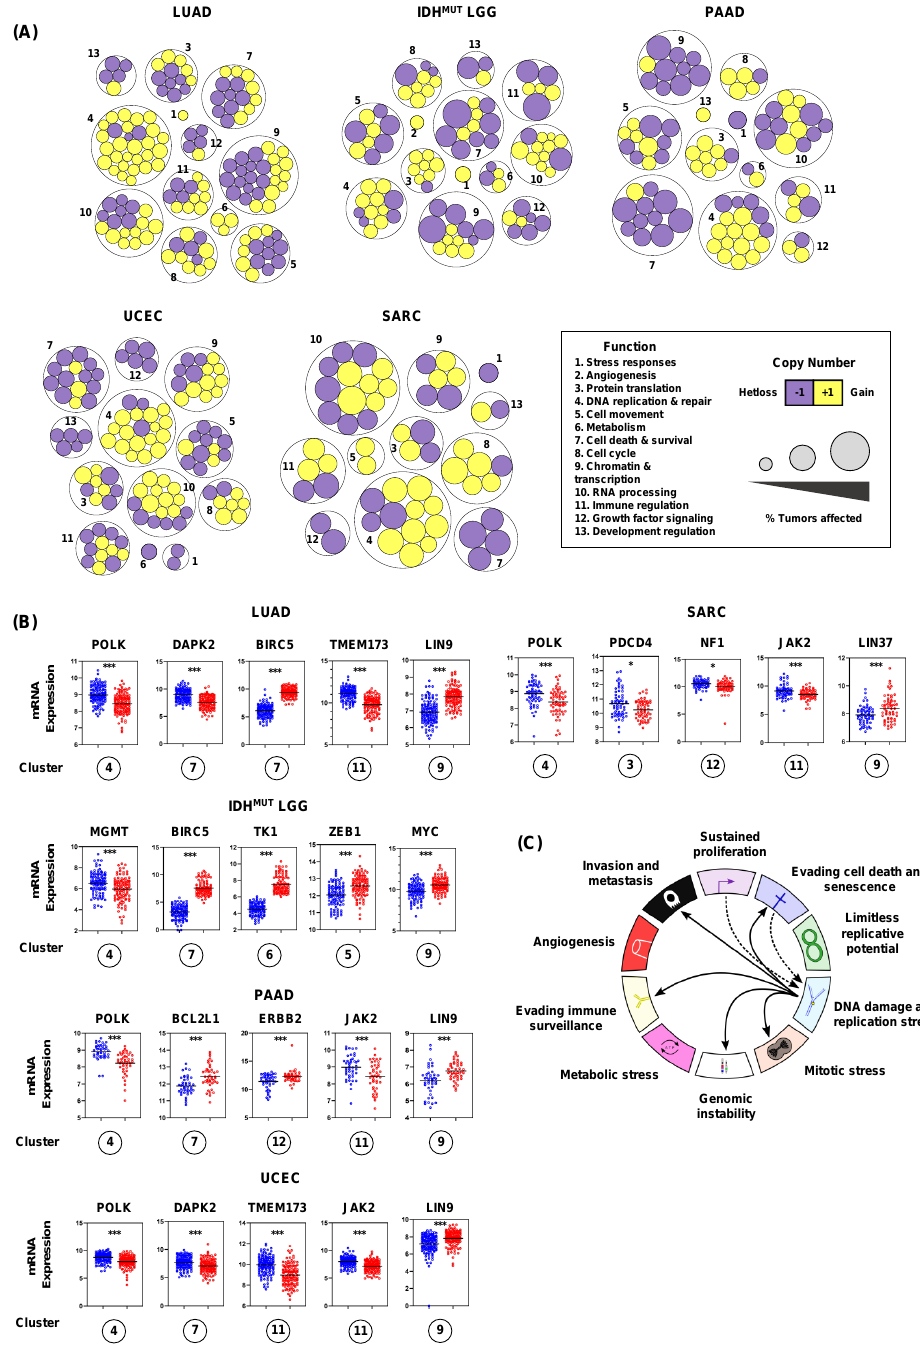
Figure 5. Recurrent copy number alterations at replication stress sensitive sites rewire transcriptional programs and dysregulate master effectors controlling several hallmarks of cancer. ( A ) MYBL2 High tumors acquire copy number alterations in essential enzymes encoded at replication stress sensitive sites. ( B ) Enriched copy number alterations observed in MYBL2 High tumors rewire transcriptional programs and dysregulate master effectors controlling several hallmarks of cancer. Statistical sig- nificance is mapped according to Benjamini-Hochberg corrected q values. q < 0.05, *; q < 0.001, ***. Circled cluster numbers map to those displayed in ( A ). ( C ) Replication stress dysregulates master effectors controlling several hallmarks of